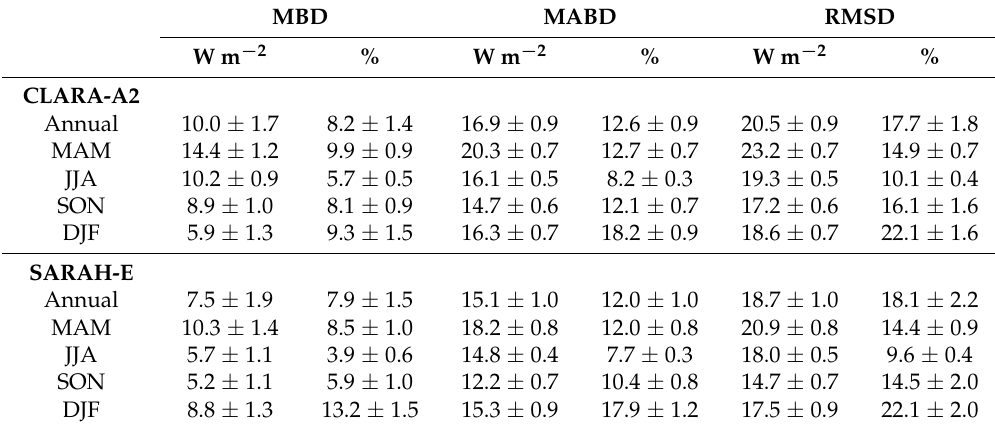
Table 2. Annual and seasonal validation results for the CLARA-A2 and SARAH-E monthly SSR datasets compared to 59 surface observation sites in China. MBD: mean bias deviation; MABD: mean absolute bias deviation; RMSD: root mean square